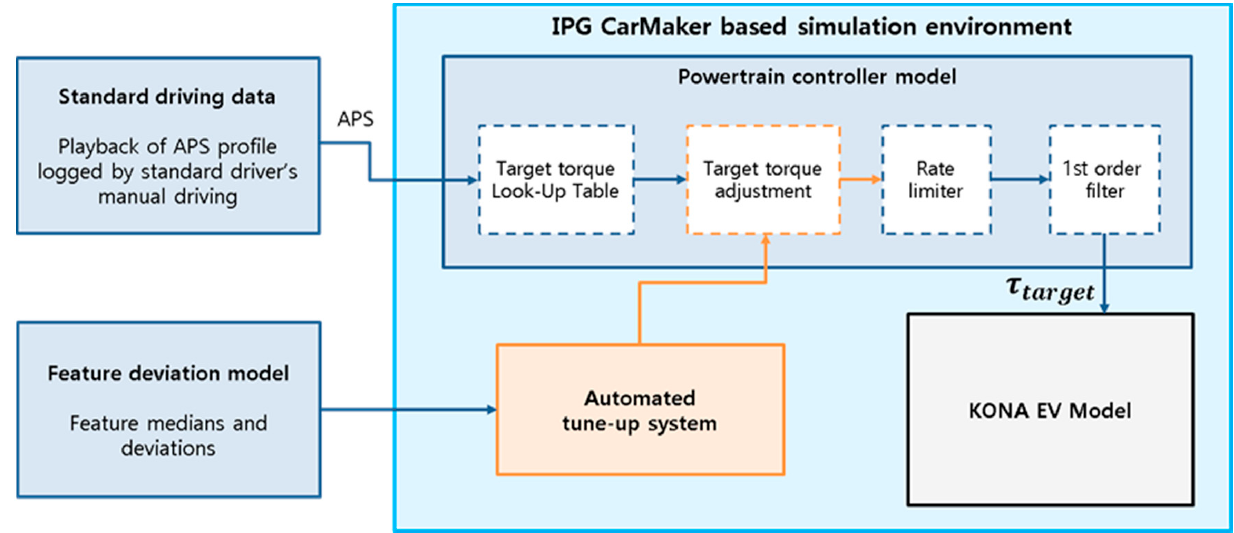
Figure 12. Simulation environment for the automated tune-up system.